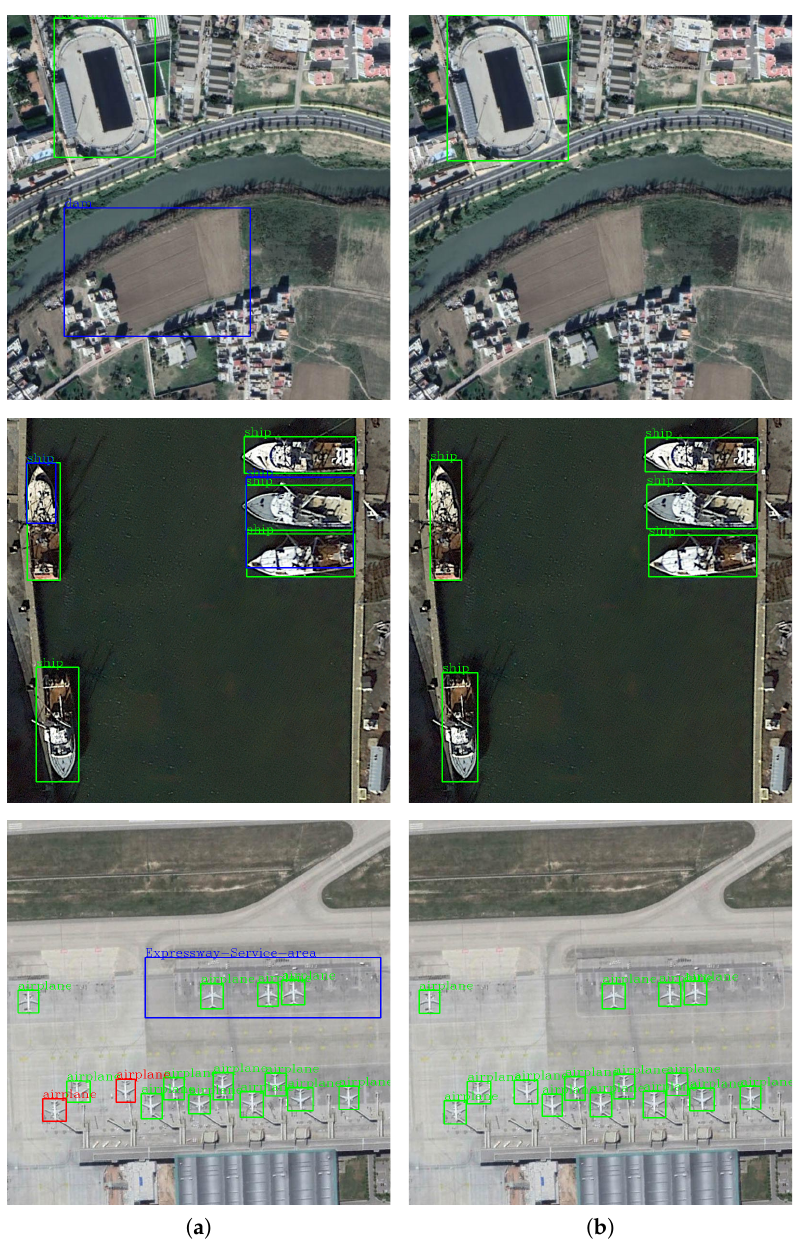
Figure 7. Some detection results comparison between FPN and the proposed method. ( a ) prediction of FPN; ( b ) prediction of the proposed method. The green, blue, and red rectangles represent TPs, FPs, and FNs,